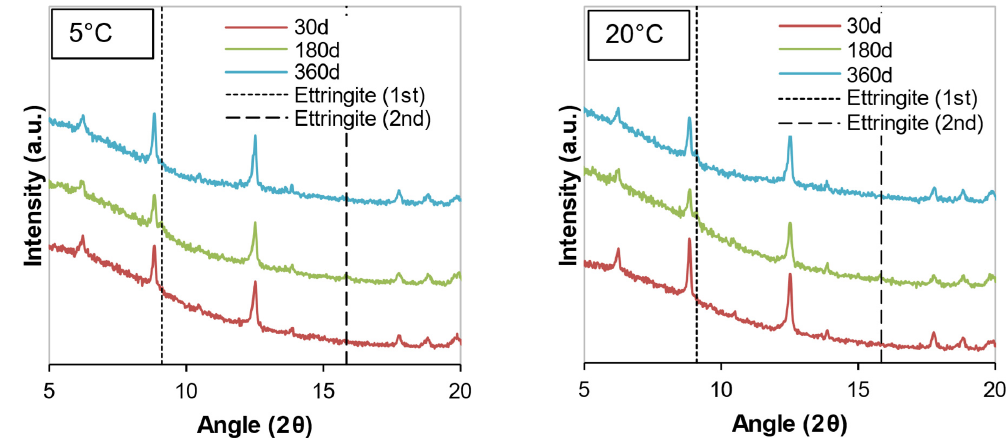
Figure 12. Diffractograms of S + C + W1 at different temperatures.